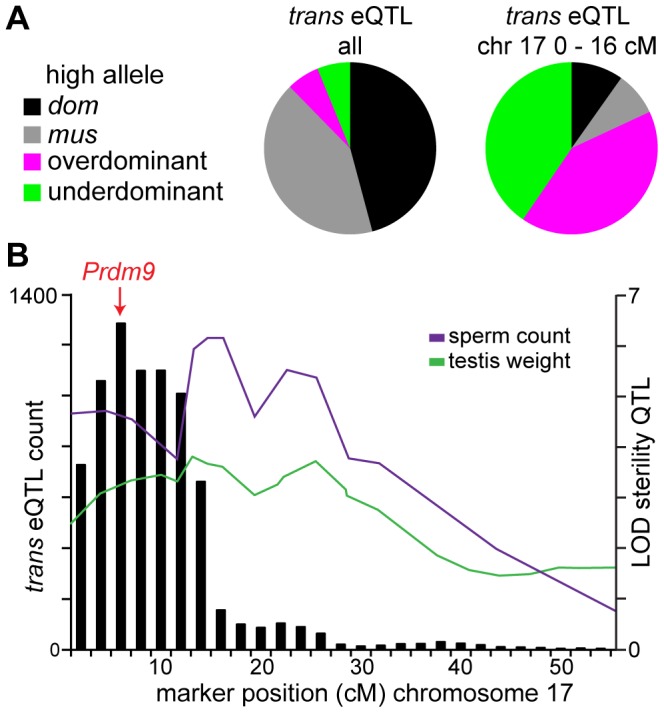
Chromosome 17 hotspot position and effects implicate Prdm9.(A) Pie charts showing trans eQTL in the chromosome 17 hotspot are largely under- or over-dominant, in contrast to the pattern seen for trans eQTL overall. (B) Histogram of trans eQTL counts for 4 cM sliding window overlaid with LOD plots for coincident sperm count and testis weight QTL.